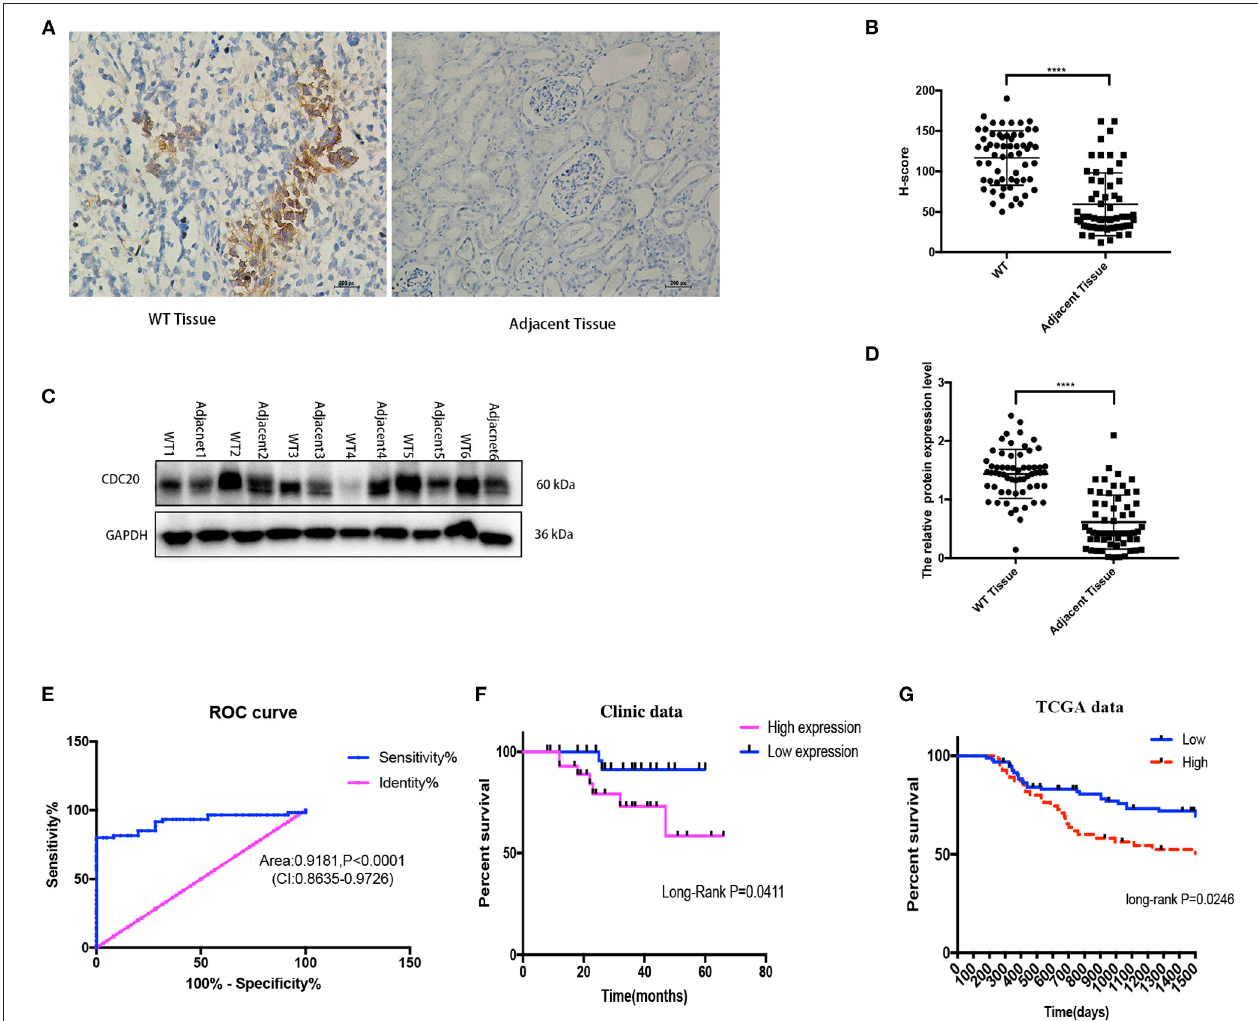
FIGURE 3 | CDC20 expression is upregulated in clinical WT samples. Representative images of IHC staining for CDC20 in adjacent tissues and different histologic grades of WT tissues (A) . The protein levels of CDC20 in six pairs of WT tissues and adjacent non-tumor tissues measured by Western blot (C) . Quantification of CDC20 IHC staining and Western blot in paired WT and adjacent tissues, respectively (B,D) . Receiver operating characteristic curve from IHC staining shows CDC20 is a marker to distinguish WT tissues from adjacent tissues (E) . Kaplan–Meier analysis of overall survival was performed to indicate that higher expression of CDC20 was correlated with poor survival of WT patients (F,G) . p -values were obtained from the log-rank test. **** p ≤ 0.0001 were obtained by Student t -test. All data are represented by mean ± SD.